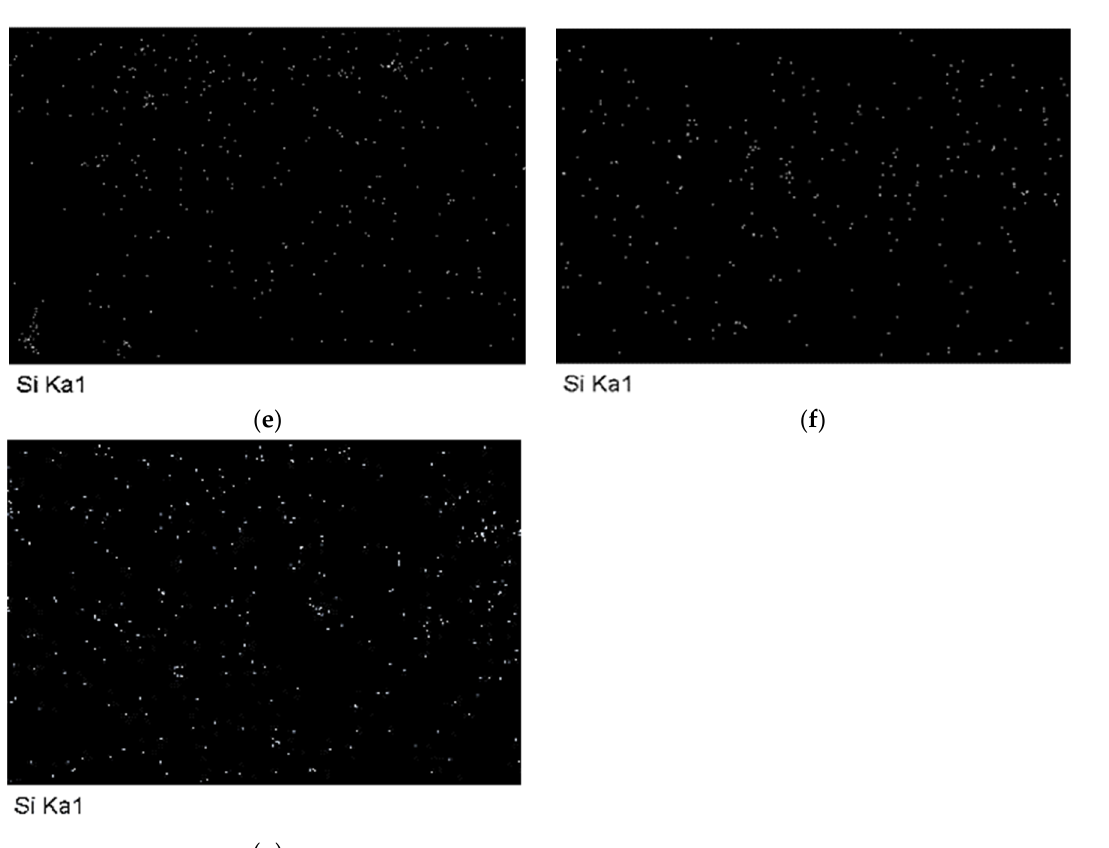
Figure 4. Silicon element on EDX mapping image of ( a ) neat PVC, ( b ) 10 wt.% untreated NM- PCB/PVC composite, ( c ) 20 wt.% untreated NMPCB/PVC composite, ( d ) 30 wt.% untreated NM- PCB/PVC composite, ( e ) 10 wt.% treated NMPCB/PVC composite, ( f ) 20 wt.% treated NMPCB/PVC composite and ( g ) 30 wt.% treated NMPCB/PVC composite.